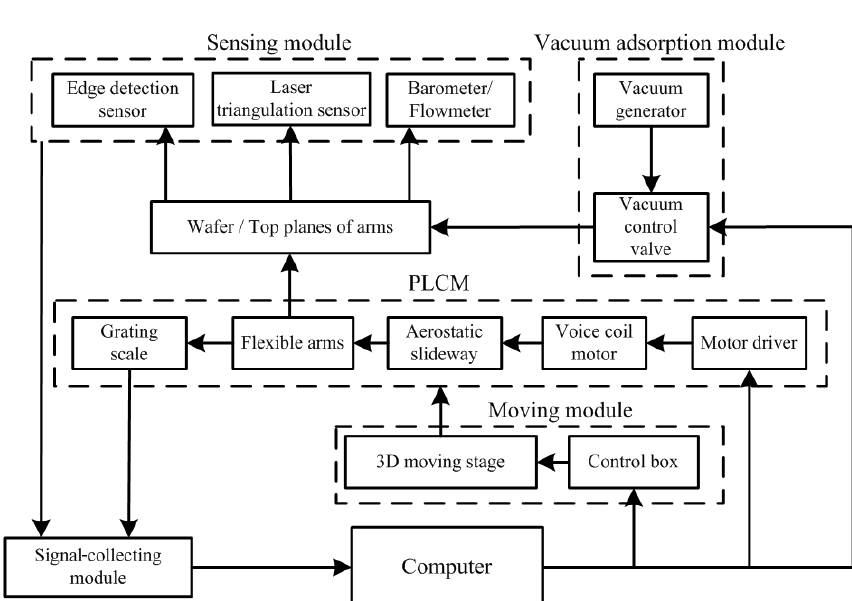
Figure 8. Schematic illustration of the experiment.